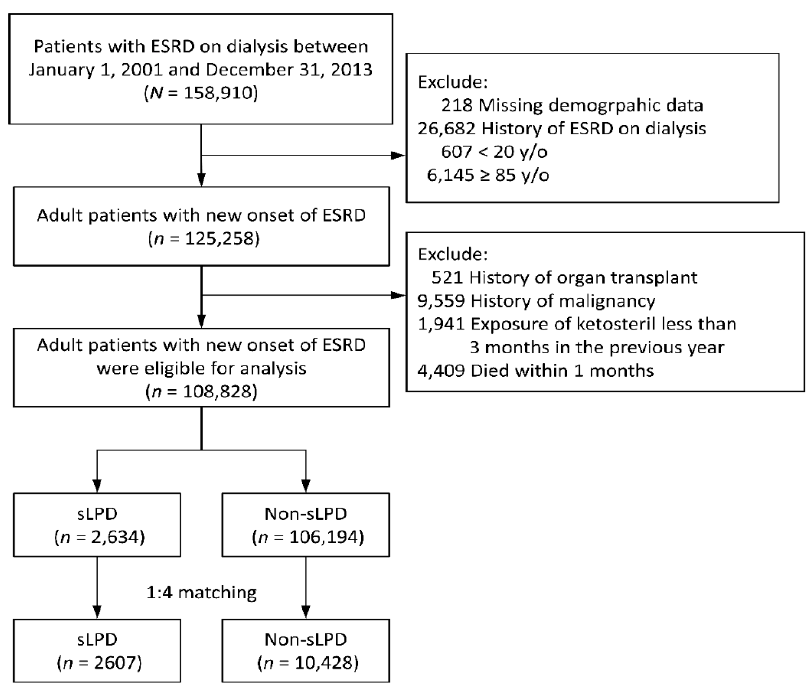
Figure 1. Inclusion of study patients. sLPD: ketoanalogue-supplemented low-protein diet. ESRD: end-stage renal disease.